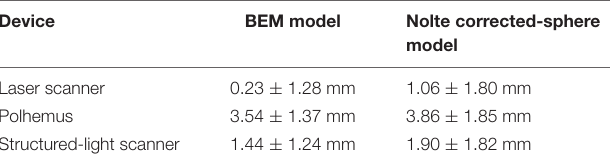
TABLE 7 | Source localization error using different co-registration methods and head models.